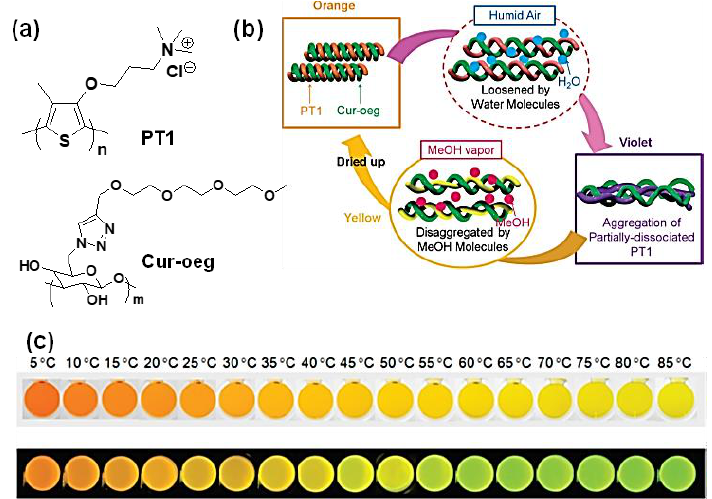
Figure 13. ( a ) Chemical structure of the polymeric components, ( b ) schematic representation of the vapor-induced color change in PT1/Cur-oeg complex film and ( c ) photographs of the PT1/Cur-oeg complex solution under the temperature control from 5 to 85 °C; upper line: bright images, lower line: fluorescence images ( λ ex = 365 nm), [PT1] unit = 0.2 mM, [Cur-oeg] unit = 0.6 mM, in water containing 5 vol % DMSO. Reproduced with permission [89].